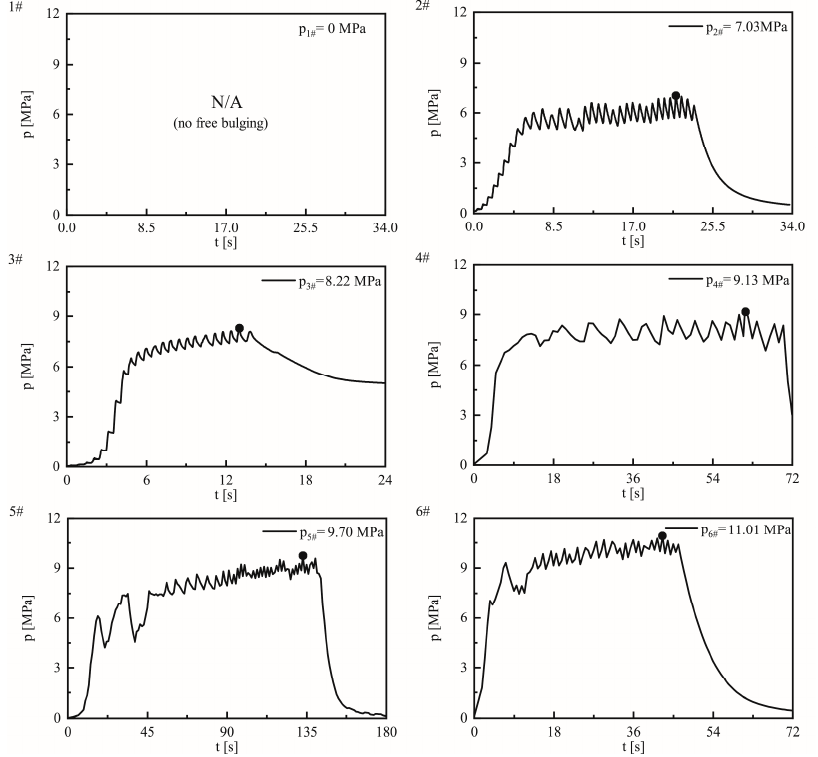
Figure 8. Pressure histories of five bi-segment cylindrical preforms during the free bulging process. Table 6. Test time and loading rate of